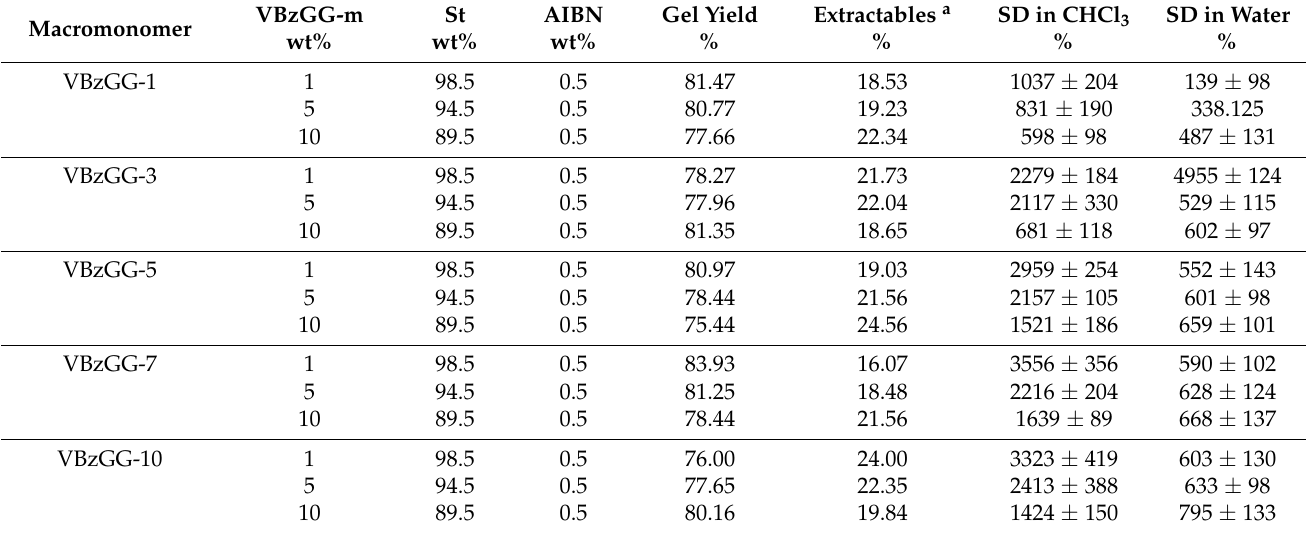
Table 1. Copolymerization conditions, amount of CHCl 3 extracted substances and conetwork (gel) yields and swelling degree (SD) of conetworks in CHCl 3 and